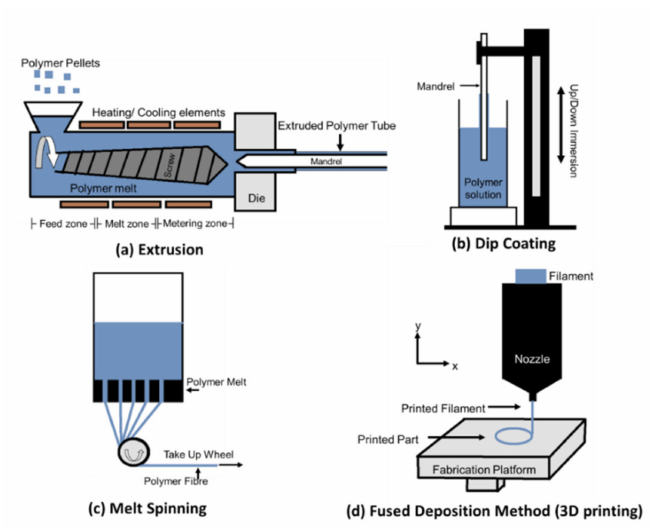
Figure 2. BRS fabrication techniques by ( a ) extrusion and passing the melted polymer through a solid mandrel; ( b ) dip coating of the mandrel in a polymer solution, ( c ) melt spinning and drawing of fibre in aligned orientation and ( d ) fused deposition method (FDM) to deposit material according to the CAD input. Images adapted from